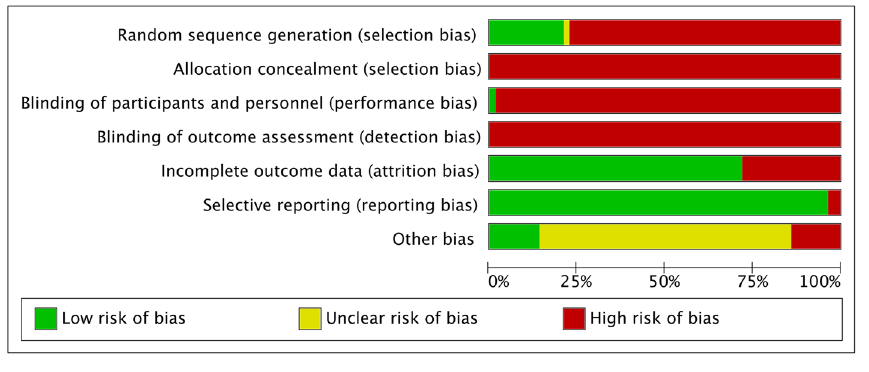
Figure 2. Overall risk of bias of the